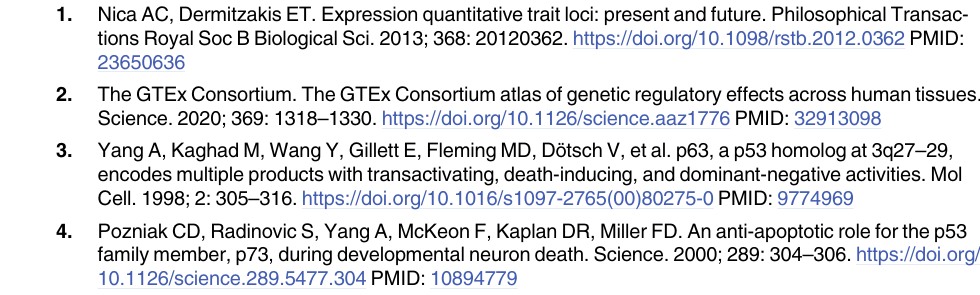
S12 Fig. Comparison of the Sin1 proteins translated from distinct transcripts. (A) Multiple sequence alignment of two isoforms of the Sin1 (MAPKAP1) protein. Protein sequences of full-length Sin1 (SIN1_HUMAN) and NTD-lacking Sin1 (BIAMA5_HUMAN) are aligned in top and bottom rows, respectively. Asterisks ( � ) indicate positions of matched residues. Red, black, and blue rectangles indicate sequences of N-terminal domain, conserved region in mid- dle domain, and Preckstrin-homology domain, respectively. (B, C) Protein structures of full- length Sin1 (SIN1_HUMAN) (B) and NTD-lacking Sin1 (BIAMA5_HUMAN) (C) predicted by AlphaFold2 with colors representing per-residue confidence score. Dotted circles indicate N-terminal domain. S1 Table. Samples from the GEUVADIS Project analyzed in this study.